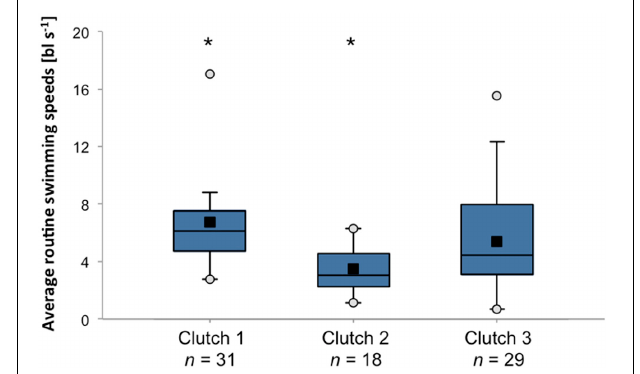
FIGURE 3 | Variation in average routine swimming speeds among and within three clutches of A. percula larvae. Box plots present average swimming speeds of 9 day old larvae in body lengths per second observed during individual trials in a larval swim chamber (Fisher and Bellwood, 2003). Black squares = mean, white circles = maximum and minimum. Asterisks indicate significant differences between clutches (Kruskal-Wallis test, p < 0 . 001). Data source: Rebecca